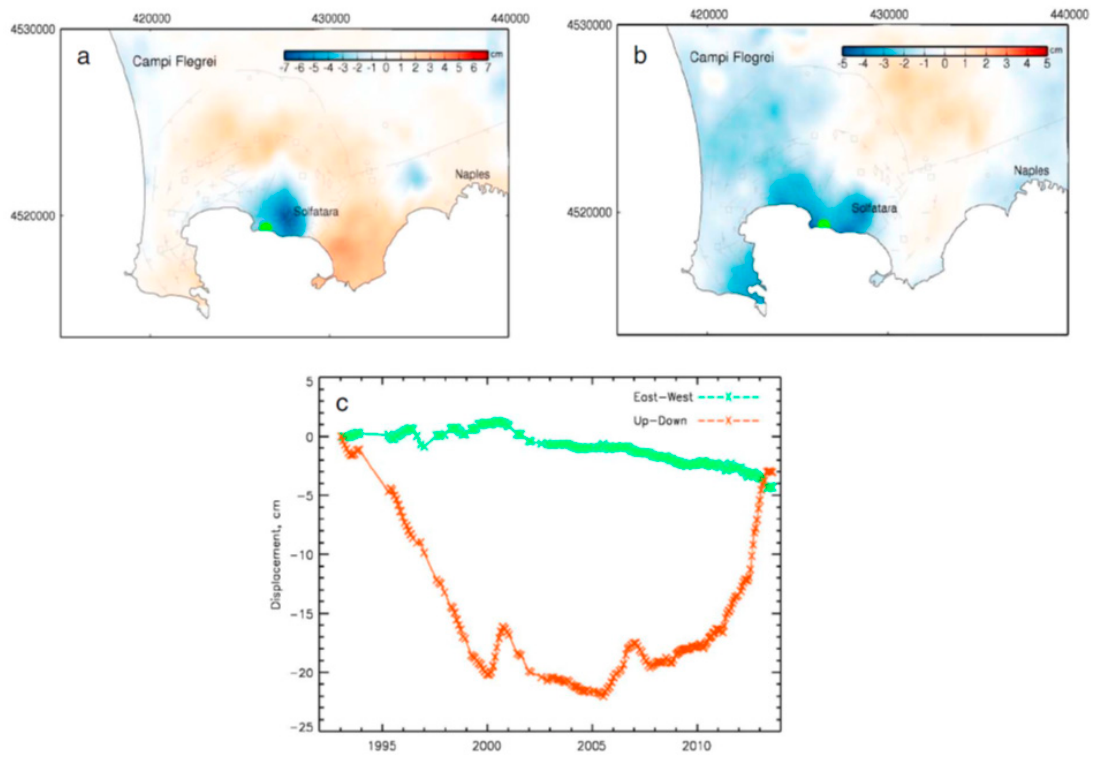
Figure 5. MSBAS results, 1993–2013, for the images detailed in Table 1. ( a ) Vertical cumulative component of deformation in centimeters, 1993–2013; ( b ) east-west cumulative component of deformation in centimeters, 1993–2013; ( c ) time series of vertical and east-west components shown in panels ( a ) and ( b ) at location of maximum subsidence, identified with the green dot. The reference location for MSBAS processing is located at 4532380, 4335351 (14.23 ◦ N, 40.94 ◦ E). Modified from